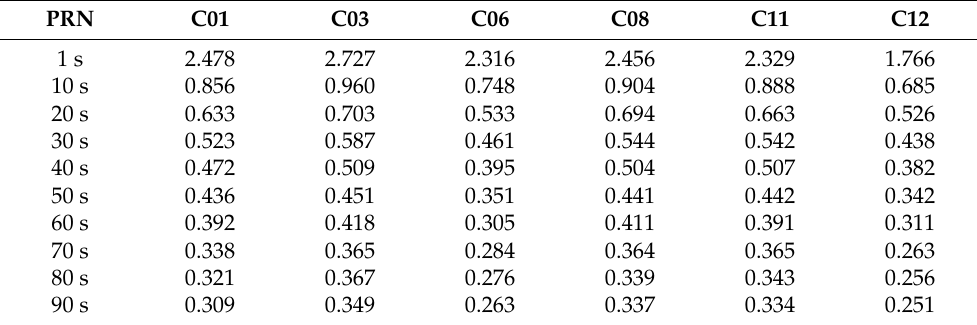
Table 1. APSD of the zenith ionospheric delays calculated with different differential interval of the zero-baseline. The sampling rate is 1 Hz and the unit is mm/